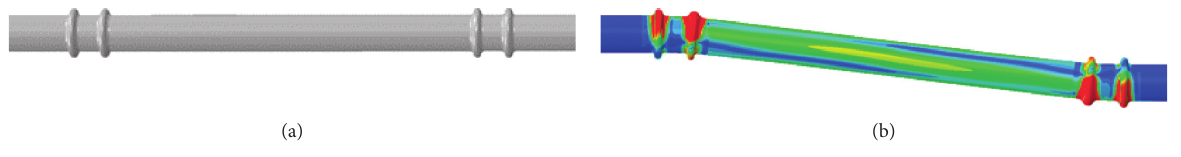
Figure 8: Von Mises contour of pipeline with double connection. (a) Before displacement. (b) After displacement.